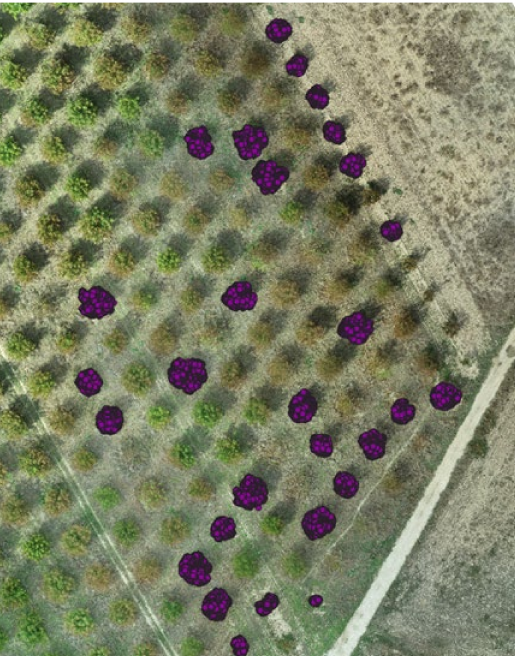
Figure 4. The projection of the point cloud (top view) of the orchard in 2D, mapped with the two methods used in the study; the ground-based system using depth camera mounted on Thorvald UGV and the orthomosaic exported from aerial images acquired using UAV.